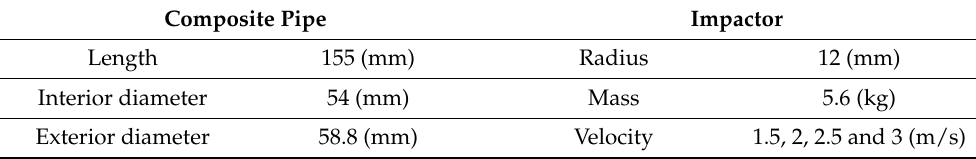
Table 1. Geometric dimensions of the composite pipe and the impactor.